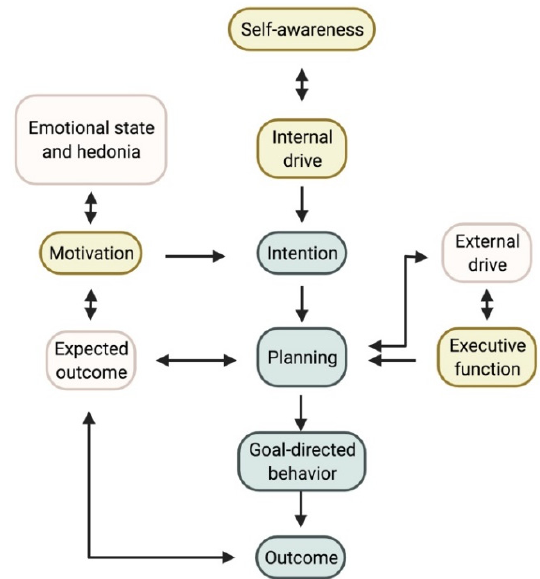
Figure 1. Proposed model for goal-directed behaviour. The three accepted subtypes and where they plug into the model are shown in yellow. Self-awareness, which is currently not yet considered a subtype, could interact with the internal drive and planning. Note on the left the importance of the hedonic state, which can affect those suffering from depression. Created with https://biorender.com/ (accessed on 27 June